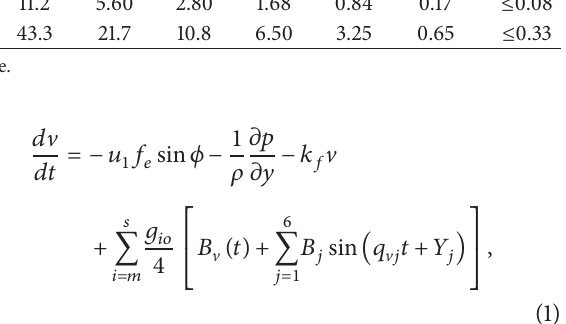
Under the gravitation of the Sun